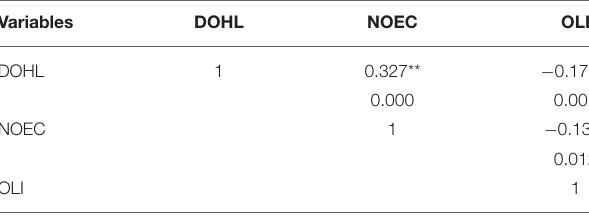
TABLE 2 | Correlation analysis between OLI, DOHL, and NOHC.